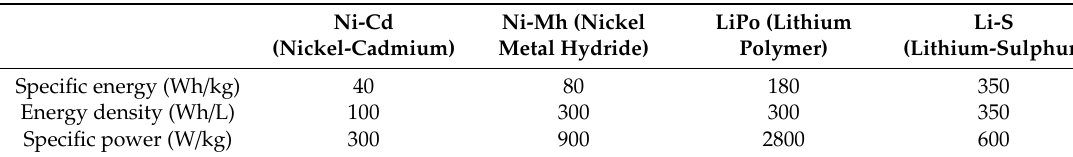
Table 5. Batteries electric characteristics